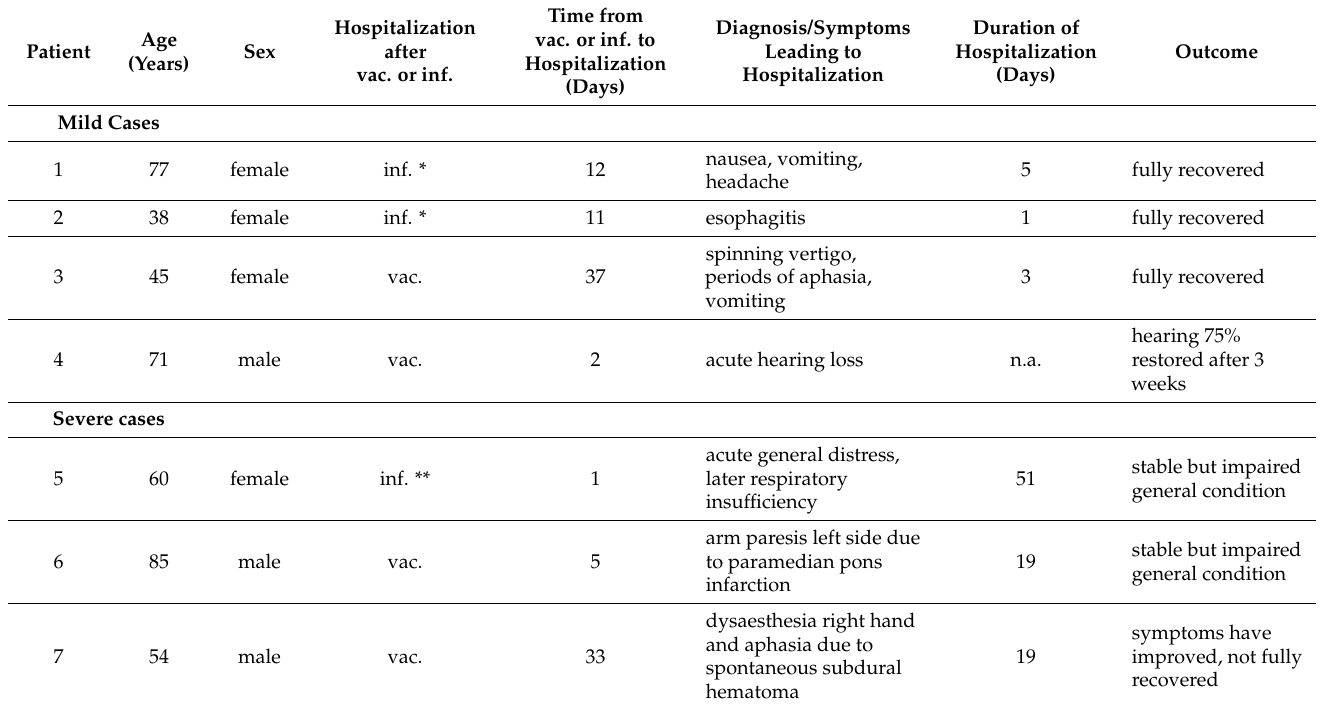
Table 5. Patients being hospitalized due to COVID-19 vaccination or COVID 19-infection with a distinction between mild and severe